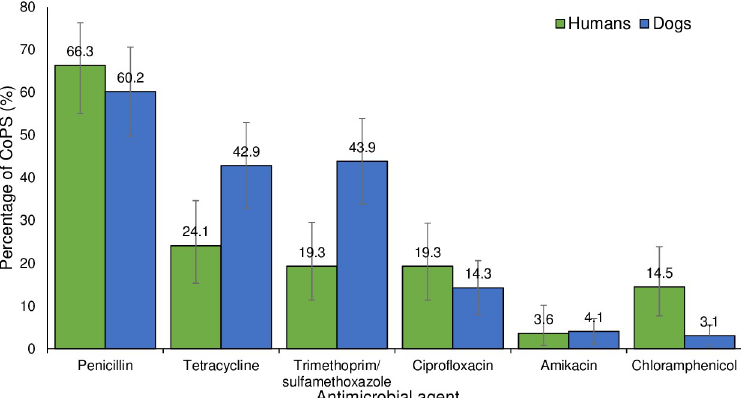
Fig 2. Frequency of detection of antimicrobial resistance in coagulase-positive staphylococci (CoPS) isolated from humans (n = 83) and dogs (n = 98).